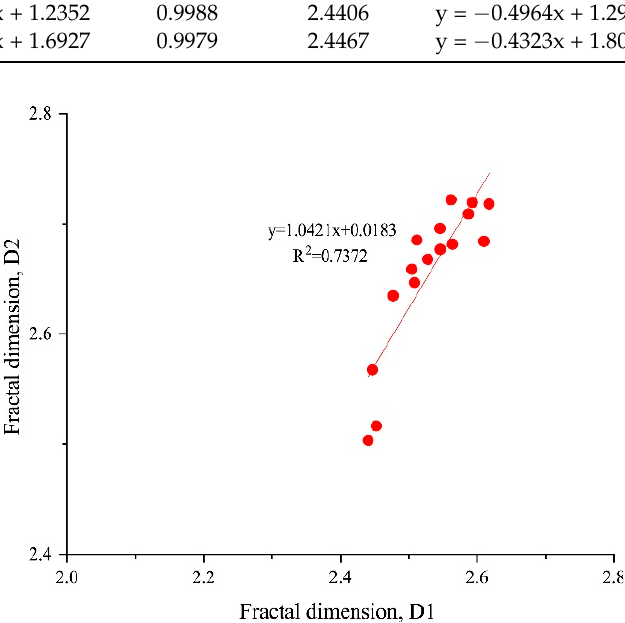
Figure 6. Relationship between fractal dimensions D1 and D2 of K 2 n 1+2 shale.